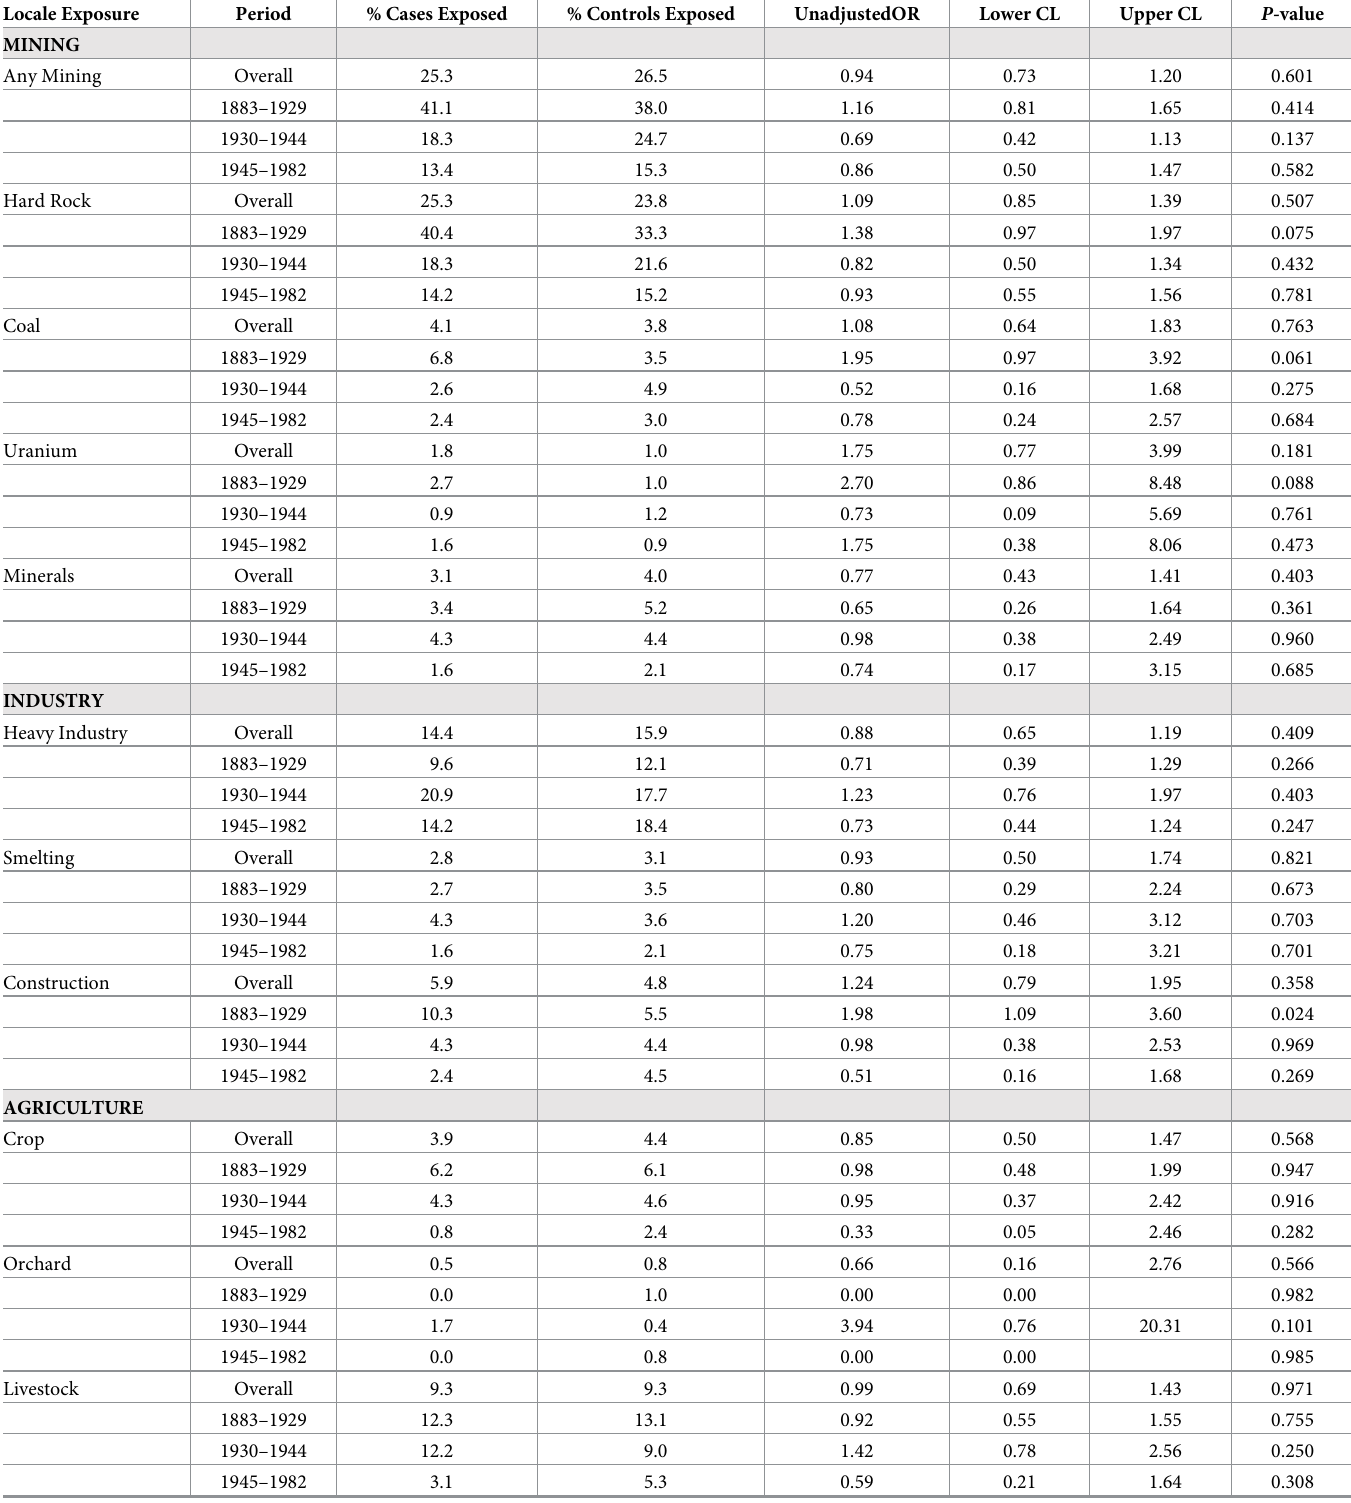
Table 3. Odds ratios for SINT from exposure to industries and